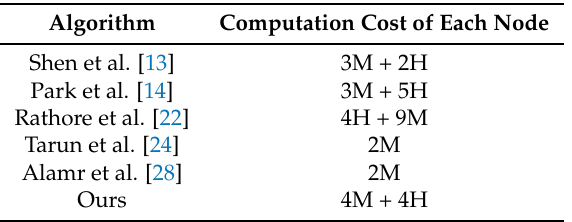
Table 2. Comparison of computational costs, where H represents hash function and M represents point multiplication over the elliptic